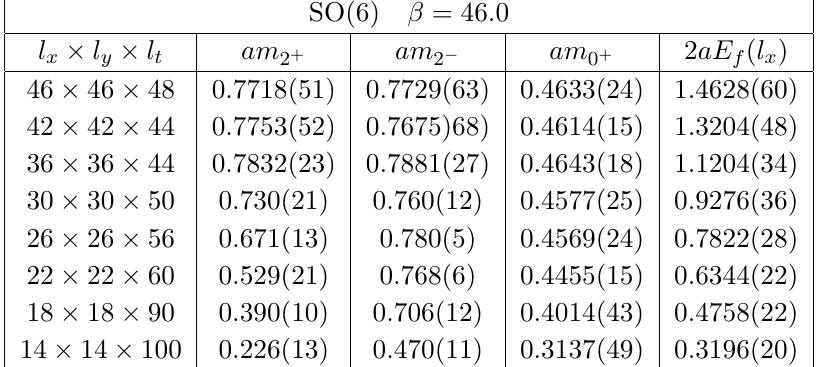
Table 8 . Lightest J P = 2 + ; 2 (cid:0) ; 0 + glueball masses on various l x (cid:2) l y spatial lattice volumes. Also twice the energy E f ( l x ) of the lightest fundamental (cid:13)ux tube that winds around the x -torus. In SO(6) at an inverse bare coupling (cid:12) = 12 =ag 2 = 46 :